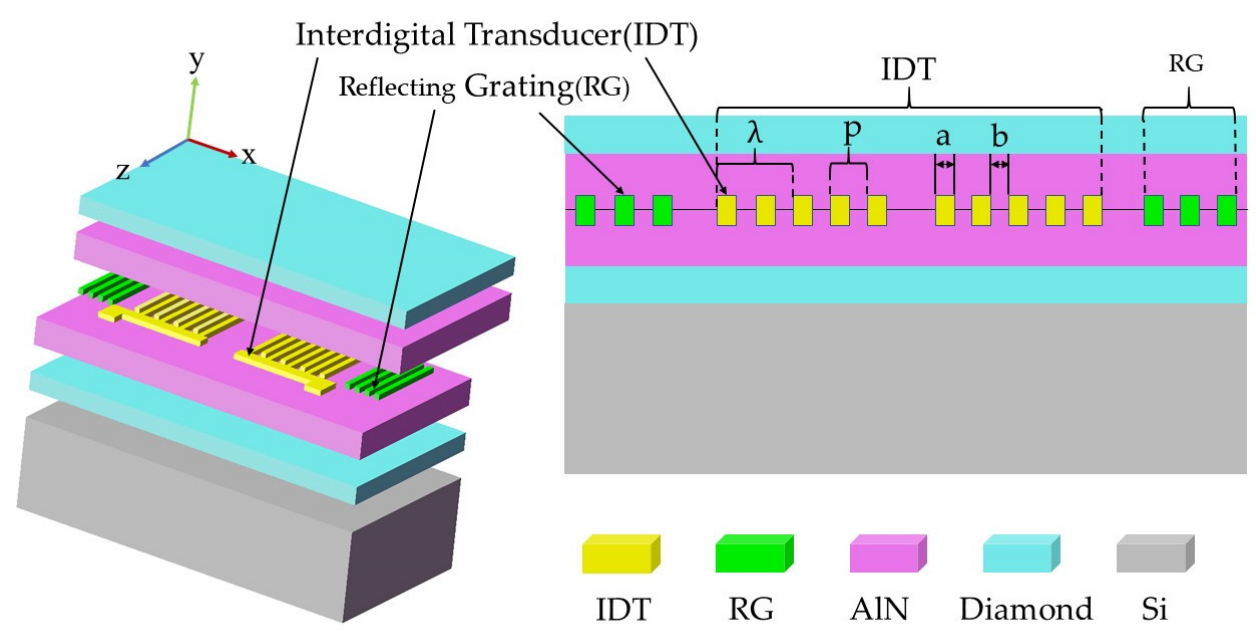
Figure 2. Structure diagram of sandwich SAW device .